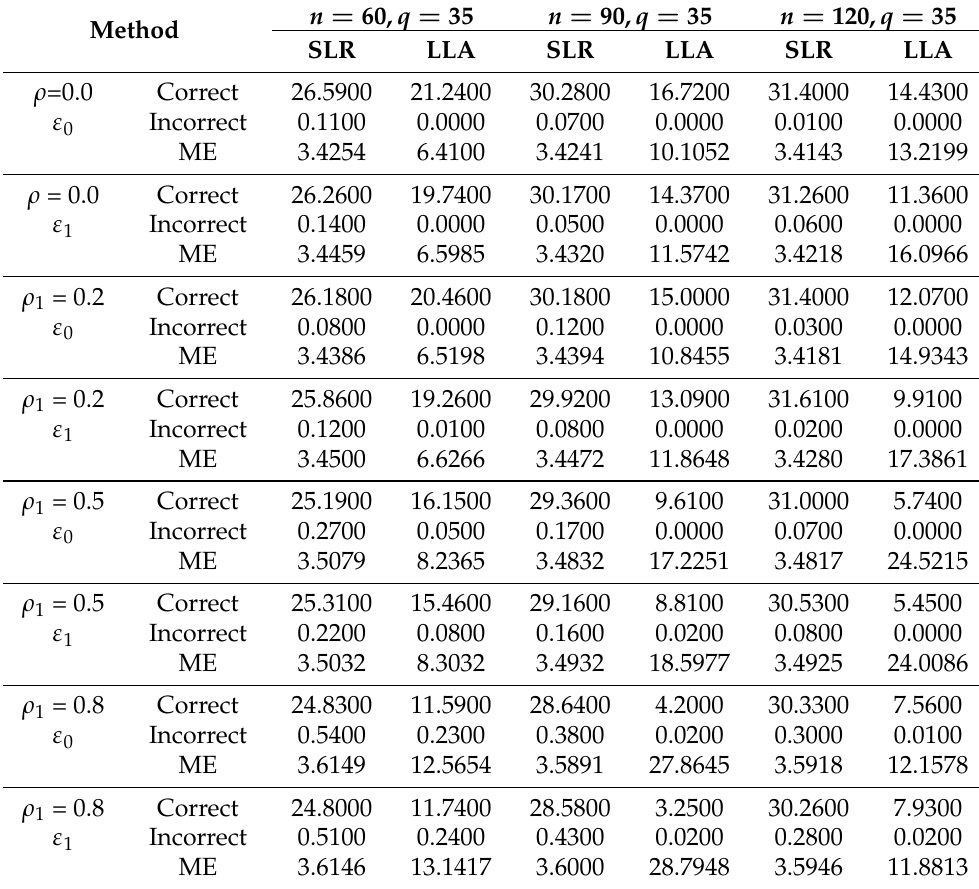
Table 4. Simulation results of variable selection via LASSO penalty function ( q = 35).